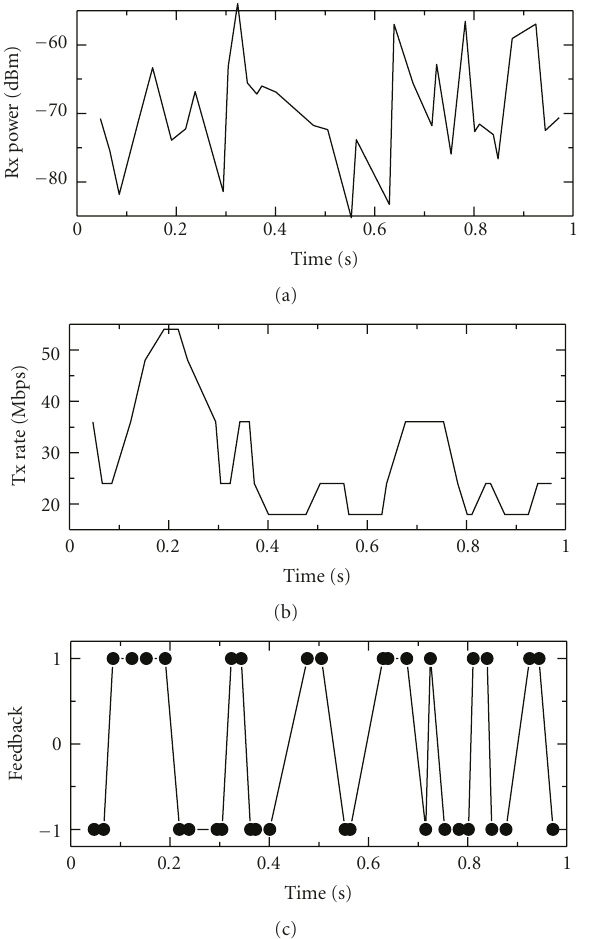
Figure 8: Data rate allocation according to feedback information.